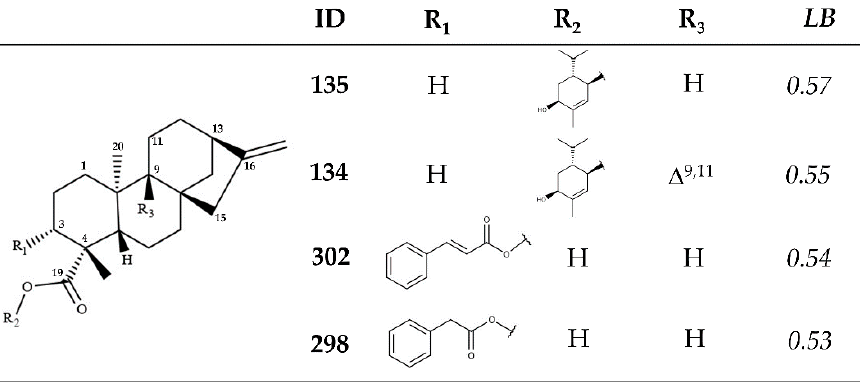
Table 1. Docking energies of the best-ranked structures from the structure-based VS for L. major PTR1. SD = standard deviation; RMSD values = root mean square deviation; and SB = structure- based probability.